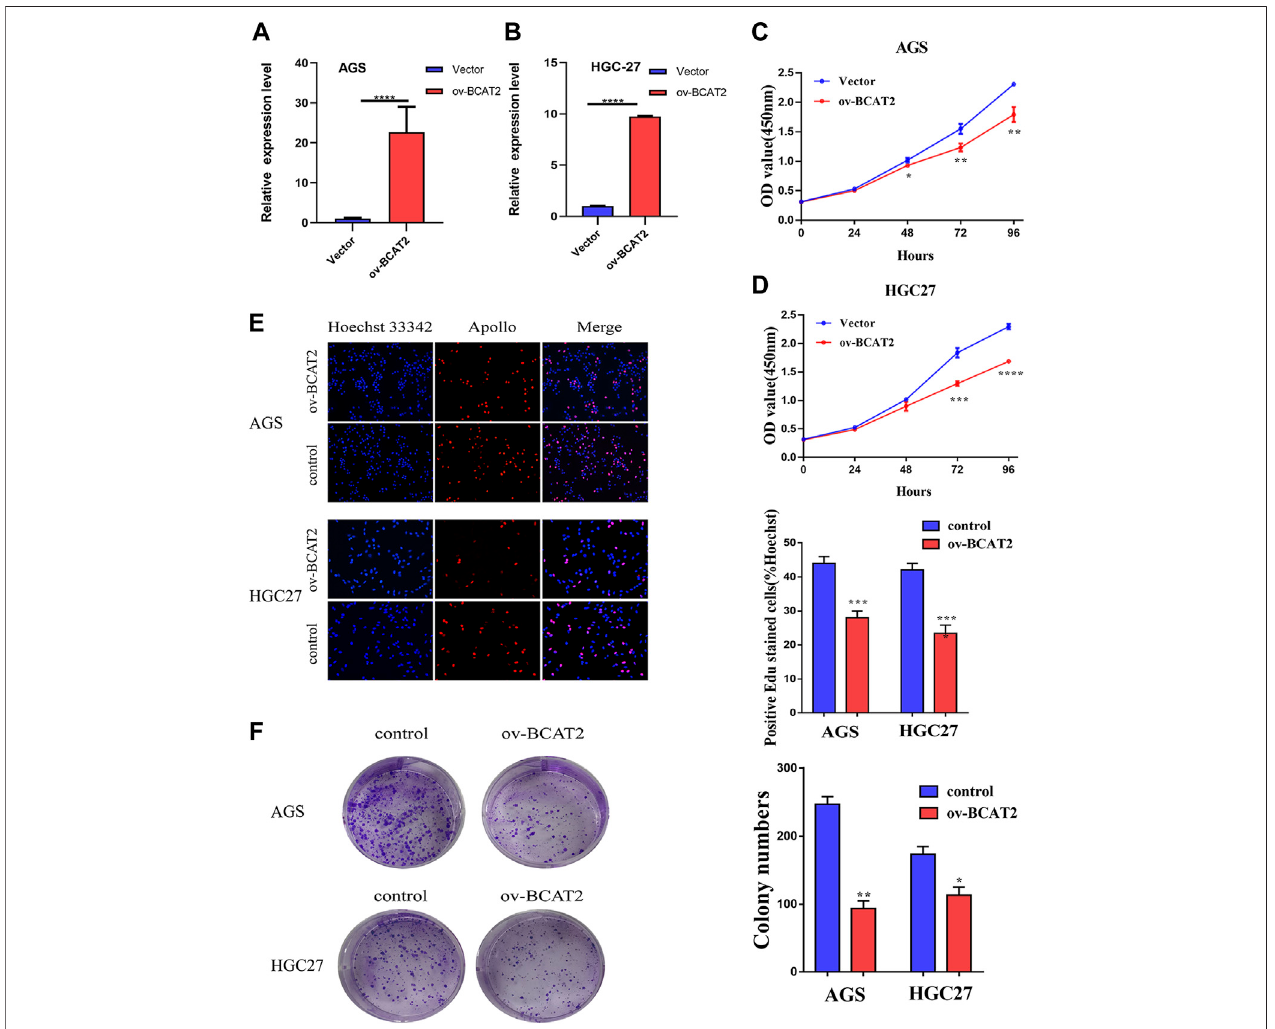
FIGURE 6 | BCAT2 suppresses the proliferative ability of GC cells. (A – B) qRT-PCR analysis of BCAT2 mRNA expression after treatment with an overexpression plasmidinAGSandHGC-27cells. (C – D) AssessmentoftheproliferationofAGSandHGC-27cellstransfectedwithcontrolvectororBCAT2plasmidbyaCCK-8assay. (E – F) Assessment of AGS cell proliferation by EdU and colony formation assays. Quantitative data from three independent experiments are shown as the mean ± SD (error bars). * p < 0.05, ** p < 0.01, *** p < 0.001, **** p < 0.0001.